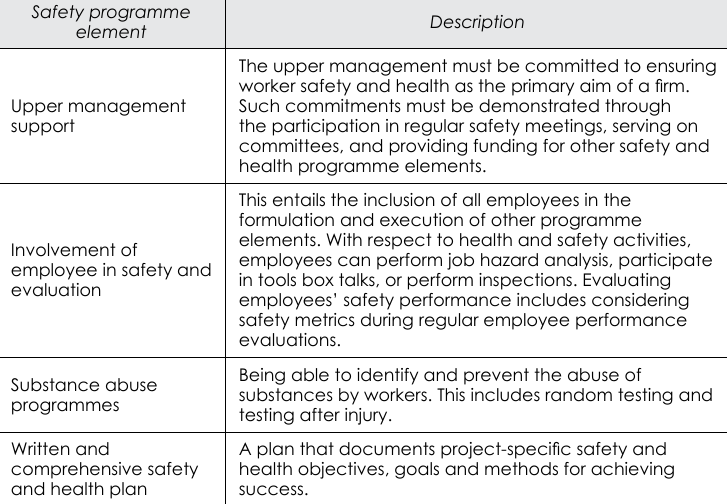
Safety programme elements and